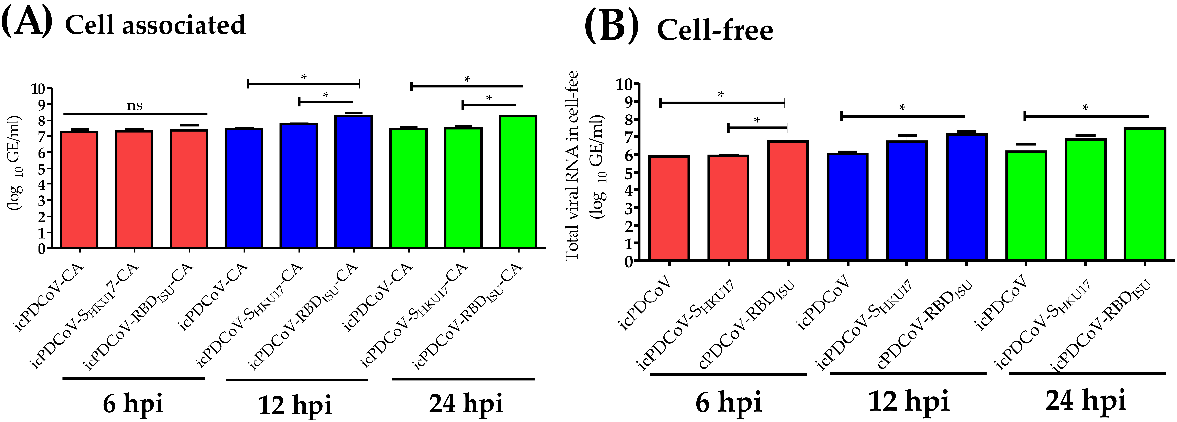
Figure 6. Comparison of viral RNA loads in virus associated with DF-1 and cell-free supernatant. The DF-1 cells were inoculated with icPDCoV, icPDCoV-S HKU17 , and icPDCoV-RBD ISU viruses at an MOI of 1. Data shown are levels of virus quantified in DF-1 from virus associated with DF-1 compared with the same inoculated DF-1 cells in cell-free fraction at 6 hpi, 12 hpi, and 24 hpi. hpi, hour post infection; GE, genomic equivalent; CA, cell-associated; CF, cell-free. One-way ANOVA with Tukey’s multiple comparisons post hoc test, * p ≤ 0.05, ns; not statistically significant.